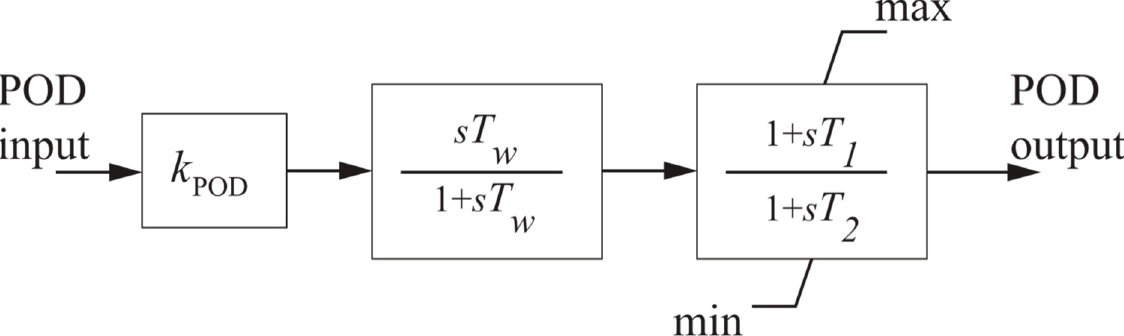
Figure 6. Transfer function of the proposed POD controller.